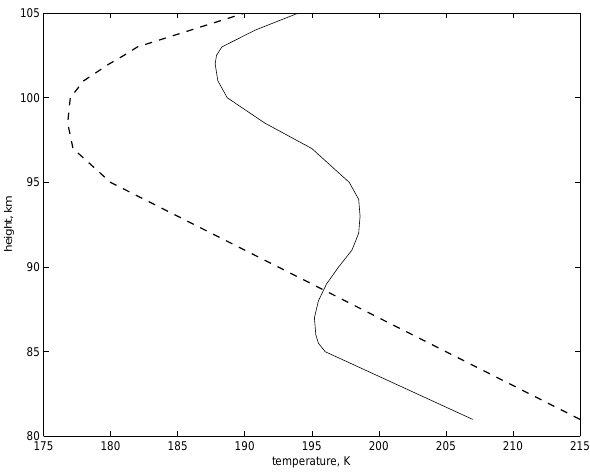
Fig. 2. Chemical heating in equinox due to atomic oxygen recom-